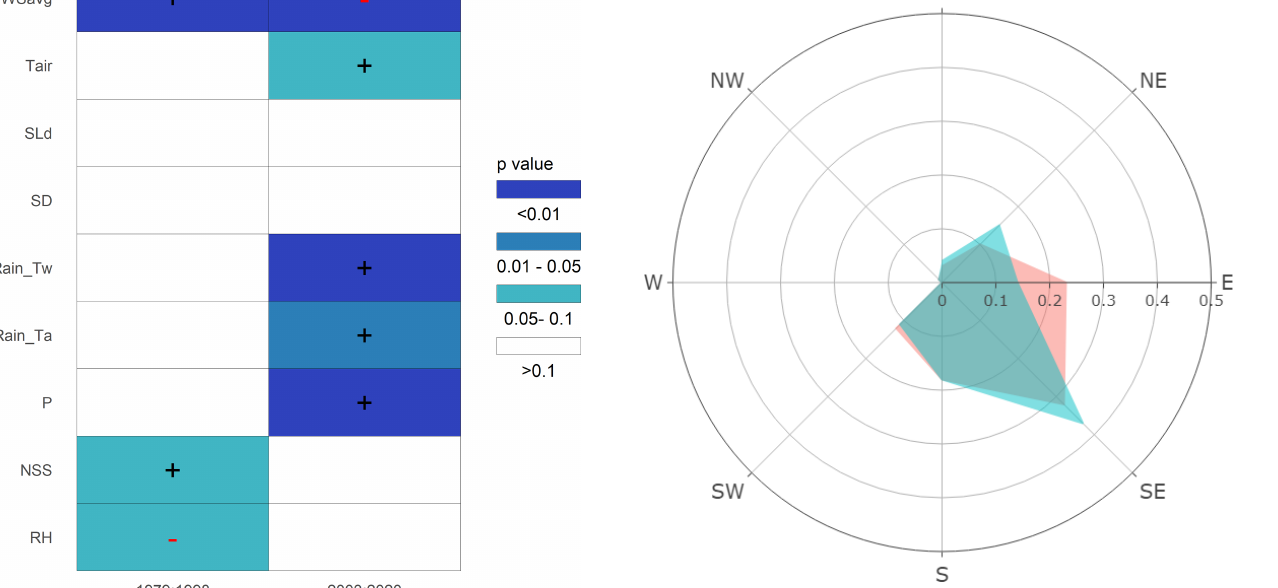
Figure 7. Trends at the LBOU meteorological station for mete- orological and snow variables (mean values) in the winter sea- son (1 October–31 May). The values represent Theil–Sen slopes. Significant Mann–Kendall trends are expressed by shades of blue ( p < 0.01, dark blue; p < 0.05, medium blue; or p < 0.1, light blue). An increasing trend is displayed by “ + ” and decreasing by “ − ”.